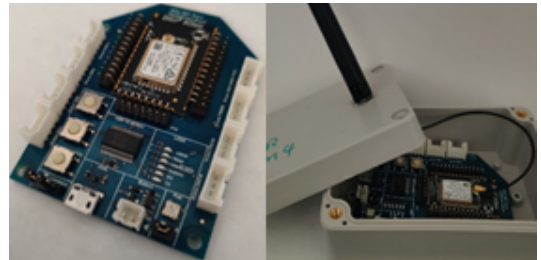
Figure 7. Digi XBee 3 Series programmable module implementing IEEE 802.15.4. in a weatherproof secure enclosure protecting the devices from the elements when deployed.